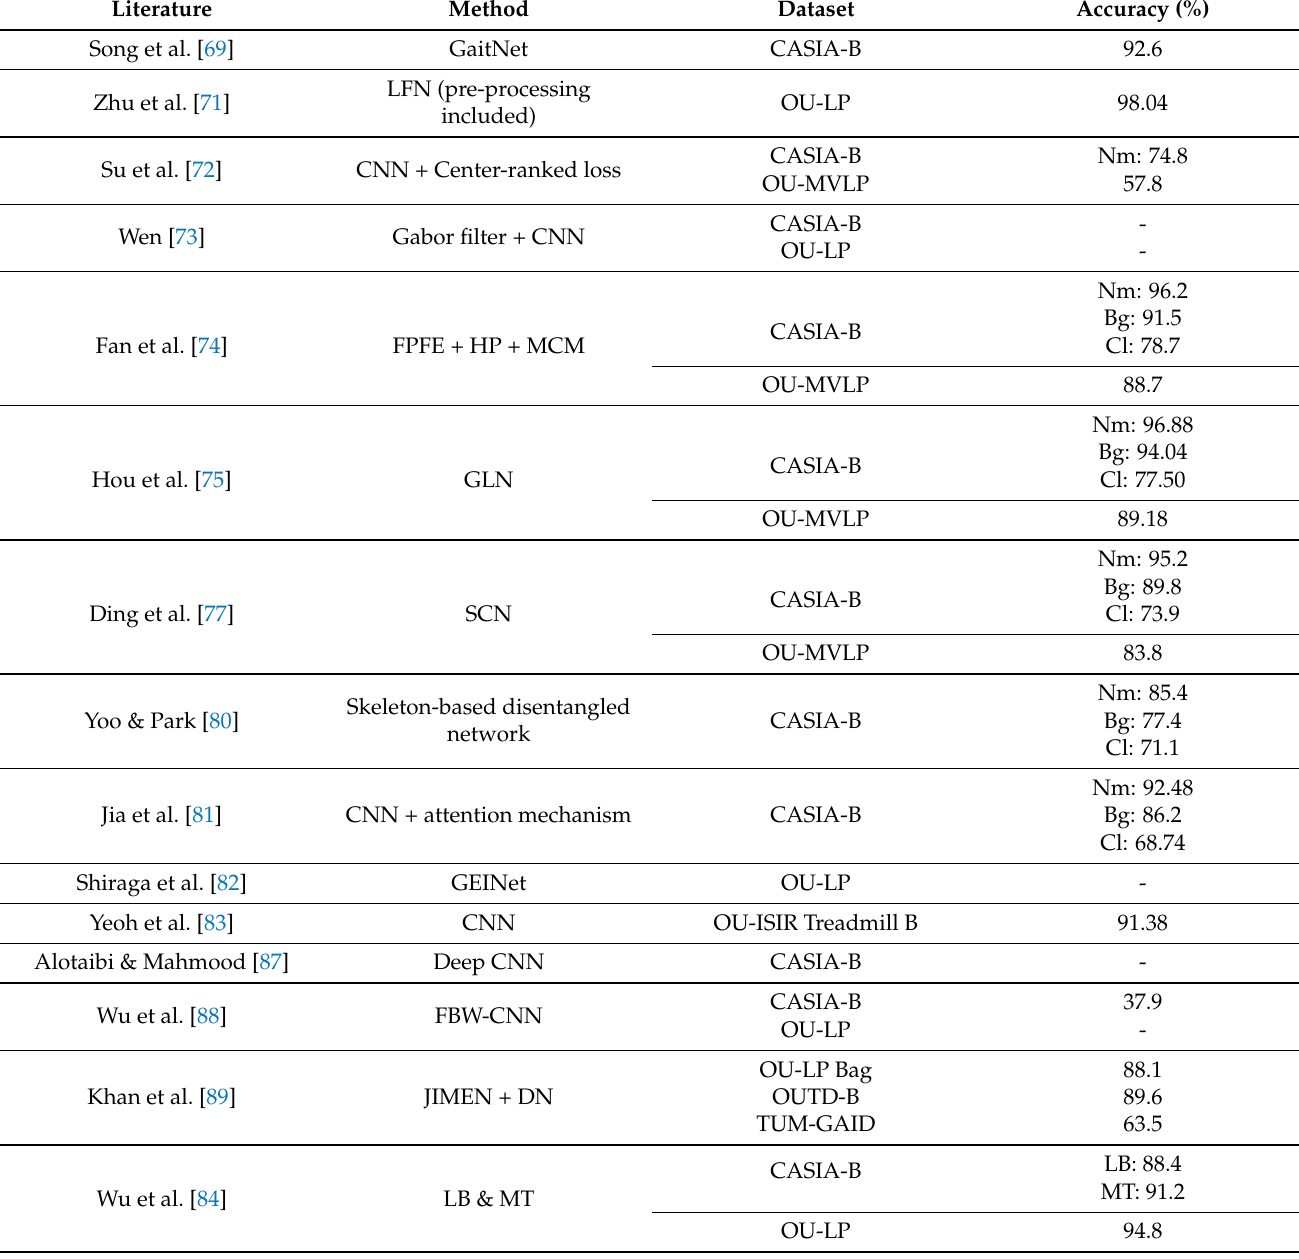
Table 4. Summary of convolutional neural network